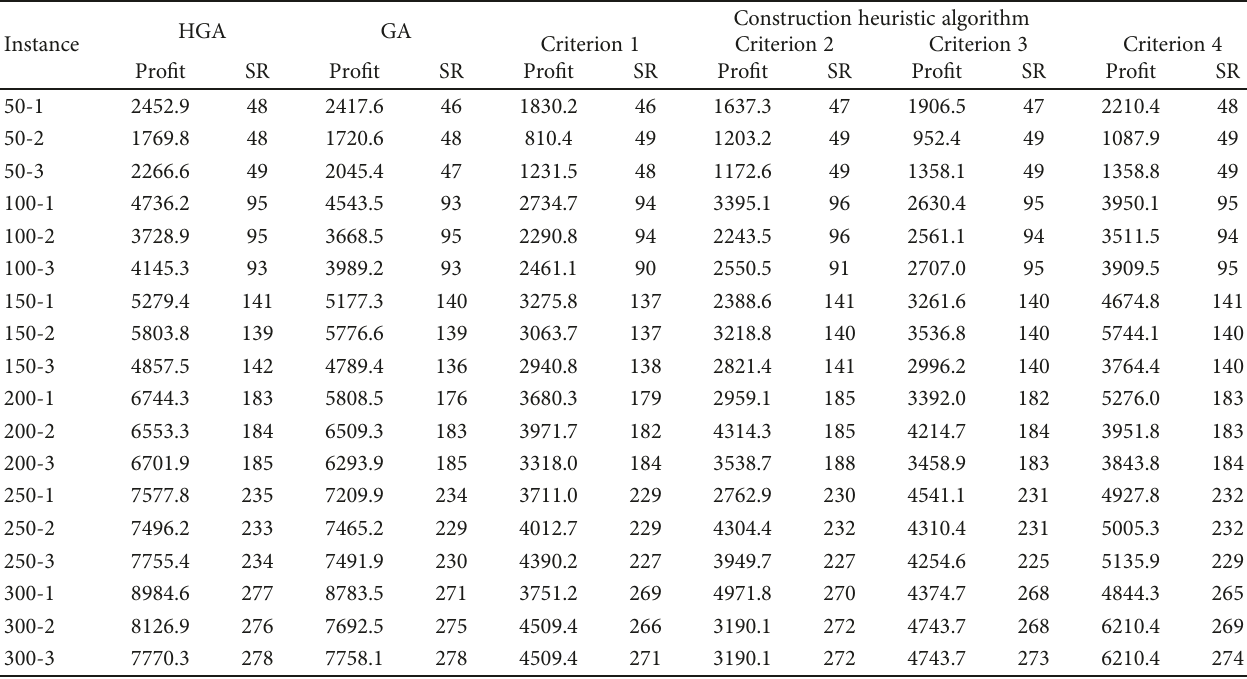
Table 2: Comparison of HGA, GA, and construction heuristic